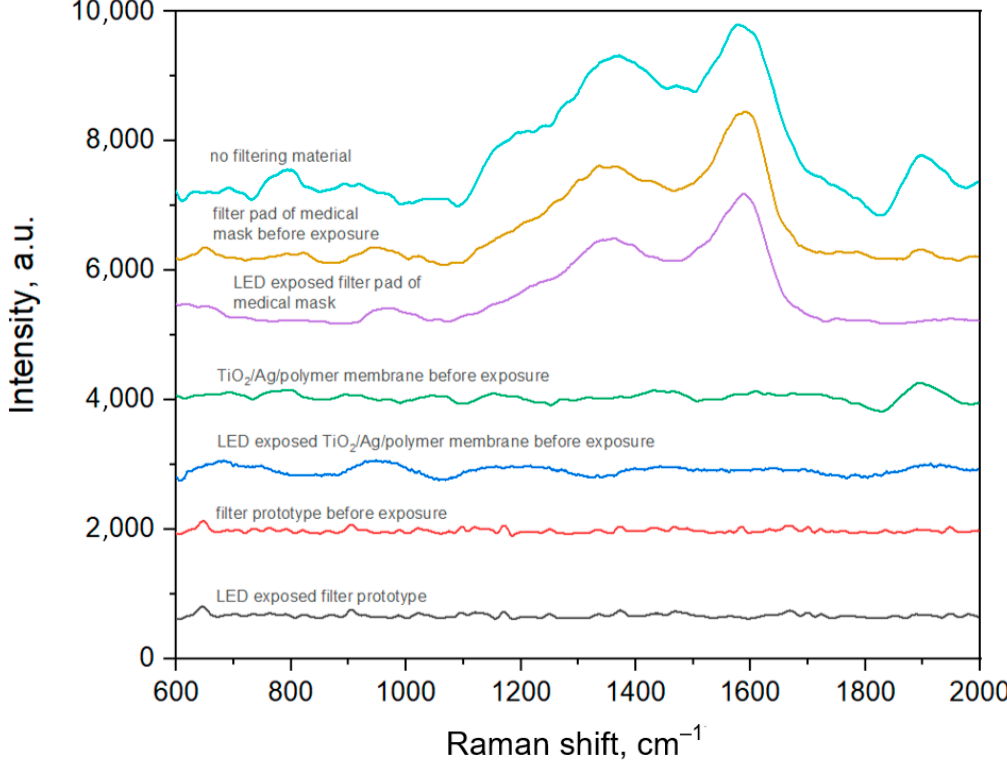
Figure 8. The results of SERS-analysis of air pulled out through the filtering materials before and after the LED exposure: average SERS-spectra for the medical mask filter pad, prototype and TiO 2 /Ag/polymer membrane are depicted.